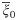
A comparison of theoretical and simulation results for the mean fractions of receptors in three states, viz., ξ¯0, ξ¯1 and ξ¯2 plotted against R0, for various substrate concentrations A0, for two different values of ℓ (indicated in the figures).